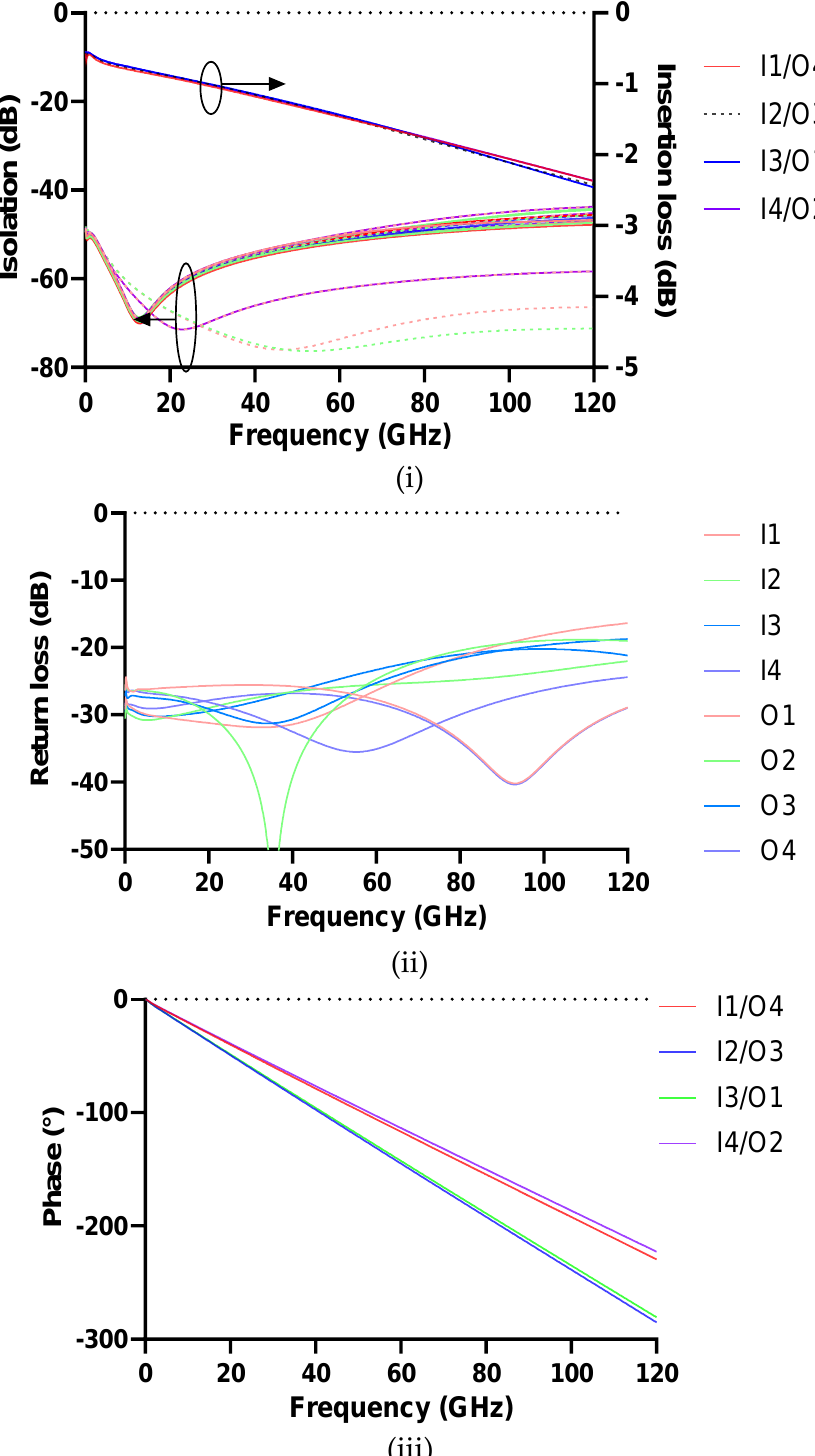
Figure 10. RF performance of set 4 with (i) showing the insertion losses of the connected paths and isolations between the disconnected ports, (ii) the return losses at all ports and (iii) the connected paths’ phases. It should be noted that no legends are included for the port-to-port isolations due to a large number of disconnected